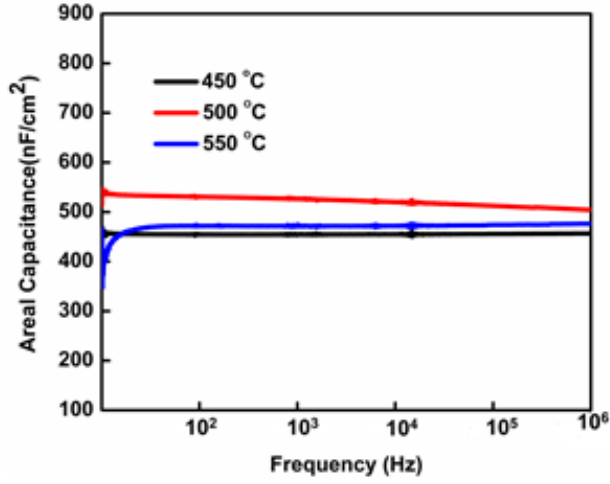
Figure 7. Areal capacitance of the WI HfO 2 ; thin films annealed at different temperatures.